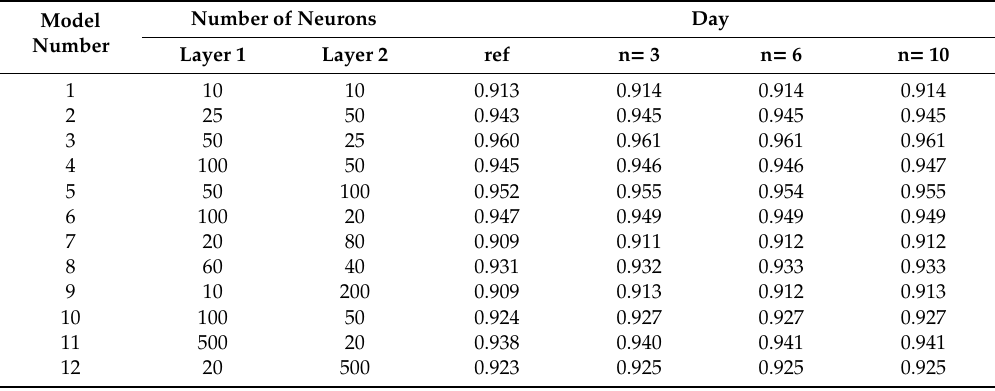
Figure 19. Analysis of correlation values, a comparison of individual wavelet settings for each time period of prediction and the number of neurons. Table 10. Correlation analysis for the reference signals and wavelet-based filtration.